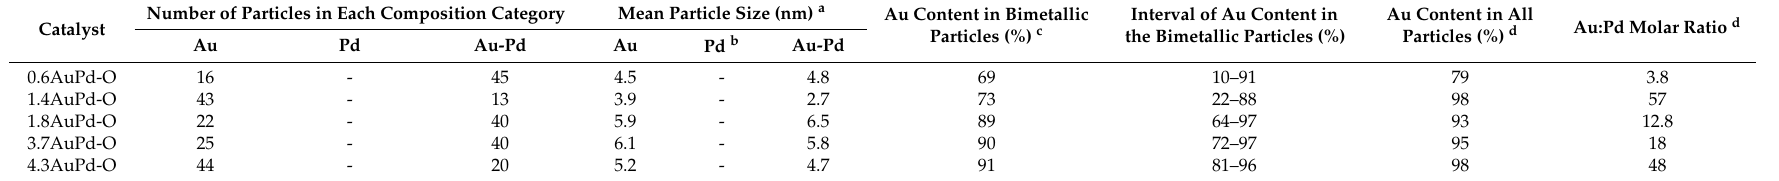
Table 2. Estimation of composition of the Au-Pd catalyst derived from Energy-dispersive X-ray spectroscopy (XEDS) analysis.